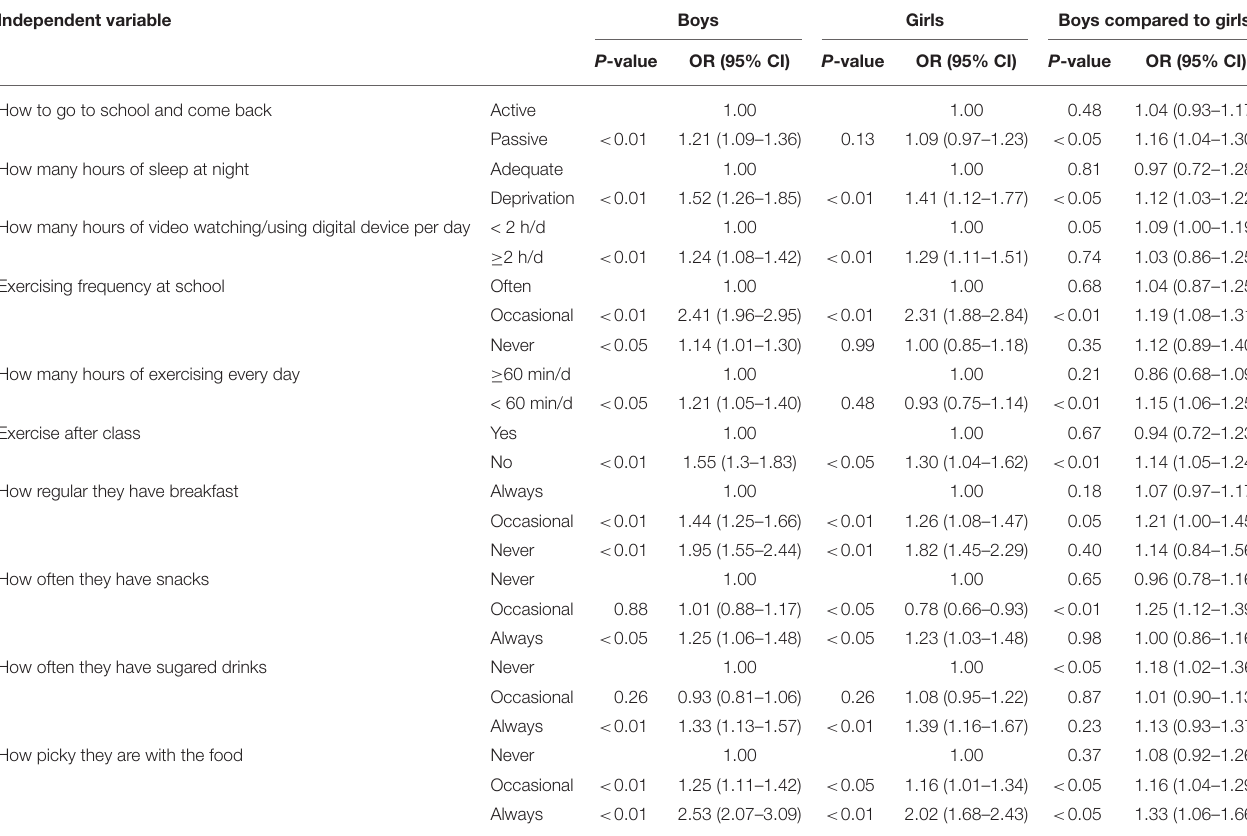
TABLE 3 | Regression analysis of the correlation between psychological symptoms and lifestyles. Independent